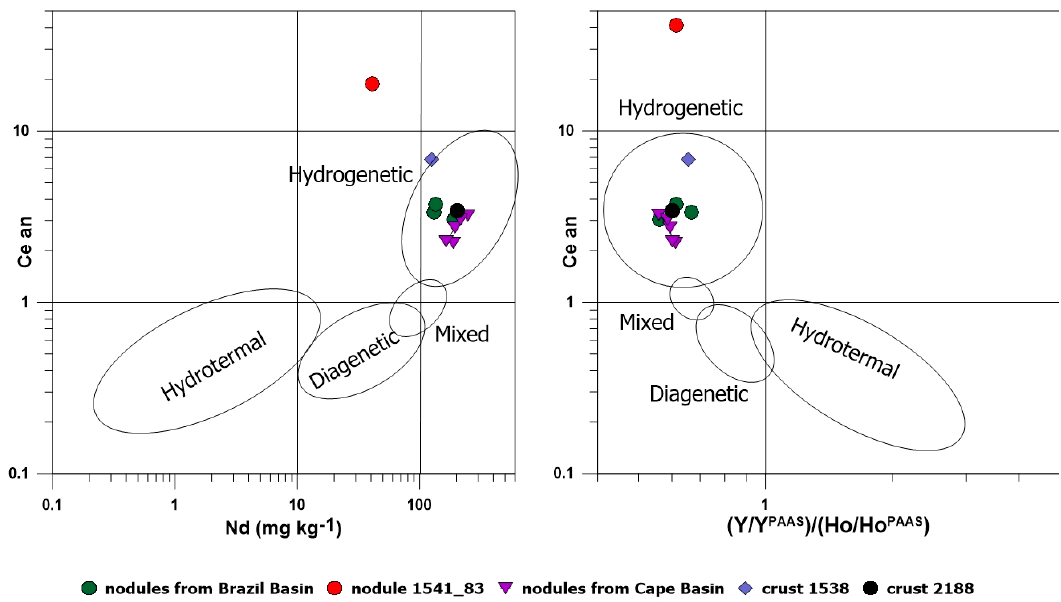
Figure 6. Composition of REE and Y in coordinates of Ce an − Nd and Ce an − (Y/Y PAAS )/(Ho/Ho PAAS ) [41] in studied crusts and nodules.